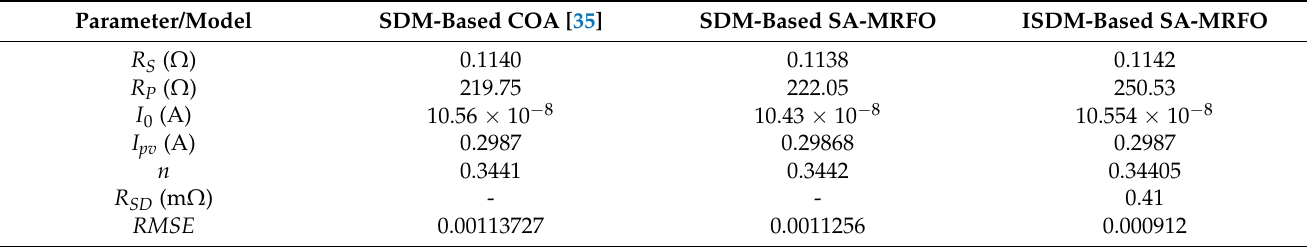
Figure 27. The measured and simulated P–U characteristics for the standard and modified single- diode models. Table 8. Experimental results obtained from the experimentally tested solar